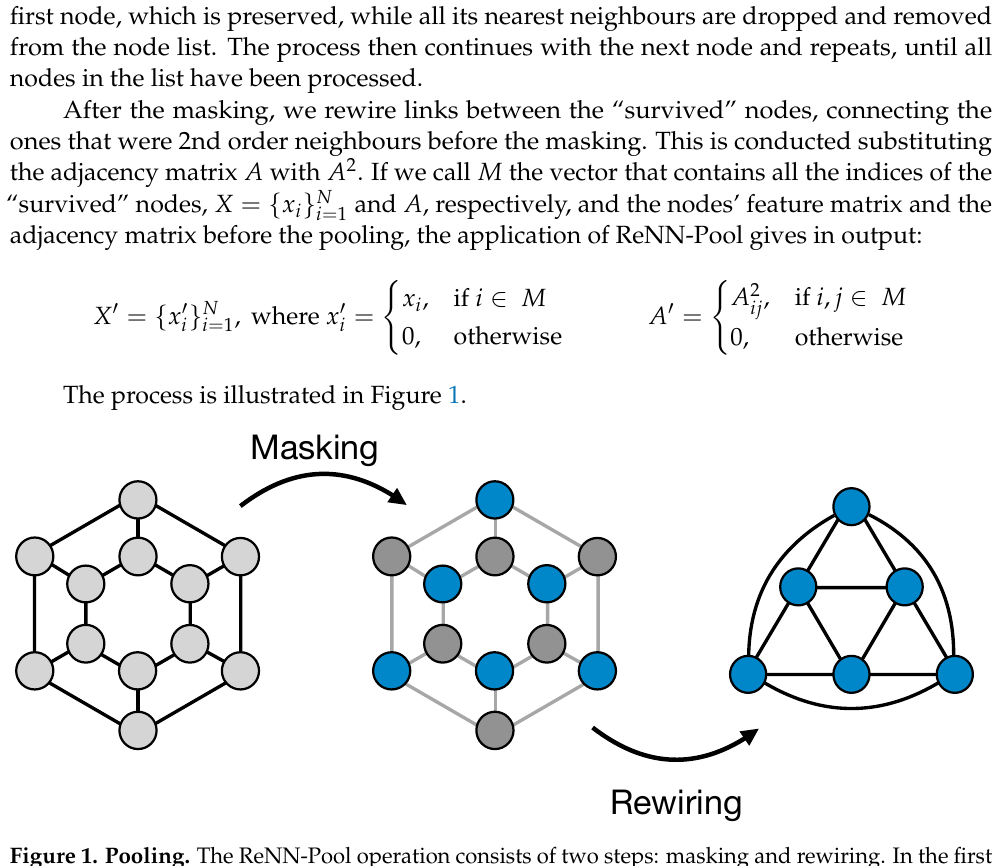
Figure 1. Pooling. The ReNN-Pool operation consists of two steps: masking and rewiring. In the first step, recursively on the whole graph, a node is selected and all its nearest neighbours are dropped. In the second step, nodes are linked to the ones that were their 2nd order